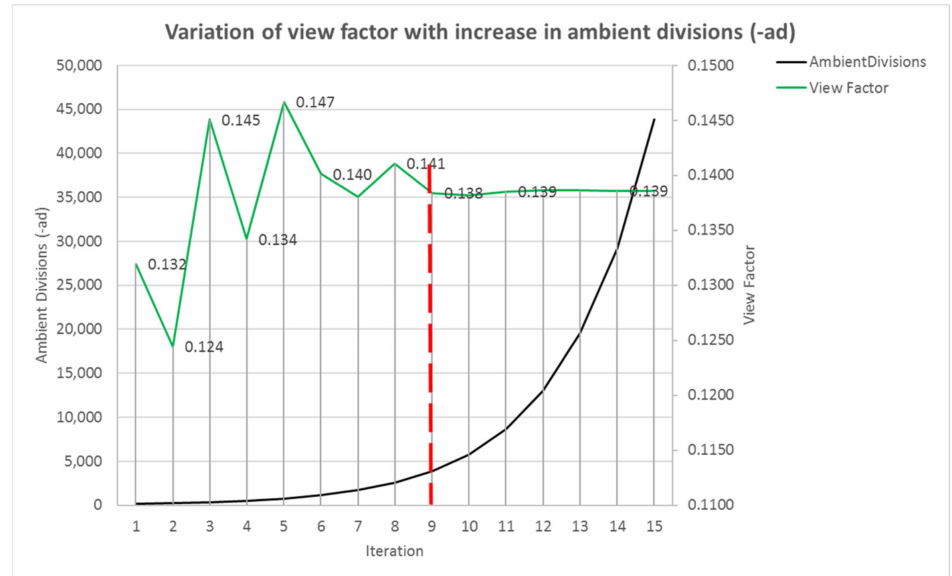
Figure 20. Variation of results with progressive increase in sampling controlled through ambient